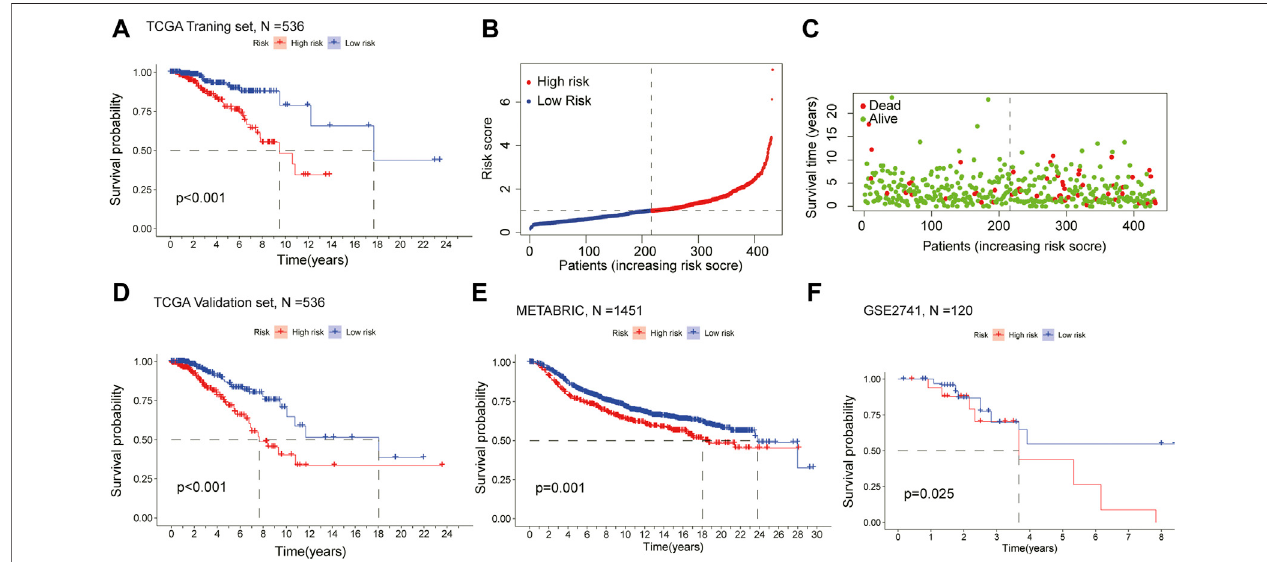
FIGURE 3| Assessmentof the prognostic model in mRNA expression database (A) Survival curve ofthe high- and low-risk groups in the training set ( n =536) (log rank test, p < 0.05) (B) The distribution of the risk scores in the training set (C) The distributions of survival status, OS, and risk score in the training set (D) Kaplan-Meier survivalcurveofvalidation set( n =536)comparingthehigh-andlow-riskgroups (E) Kaplan-Meier survivalcurveofthehigh-andlow-riskgroupsintheindependenttest set METABRIC ( n = 1451) (F) Kaplan-Meier survival curve analysis in the independent test set GSE2741 ( n = 120) comparing two risk groups. All the K-M survival analyses use log-rank tests to determine signi fi cant differences between two groups, p < 0.05.